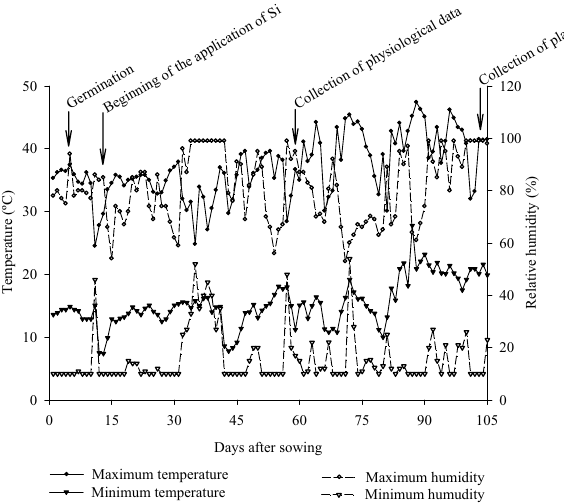
Figure 8. Maximum and minimum temperature (°C) and maximum and minimum relative humidity (%) recorded during the development of the